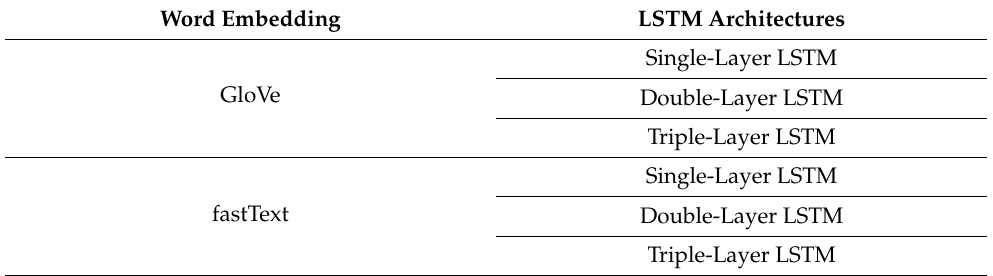
Table 2. Research